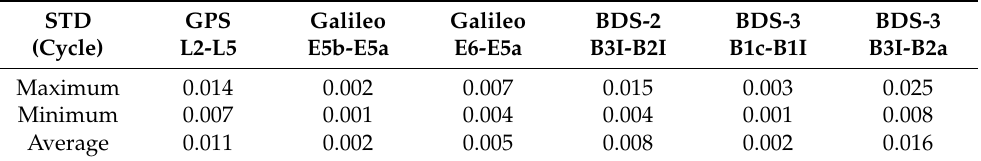
Table 3. Daily STD statistical results of GPS/Galileo/BDS-2/BDS-3 EWL